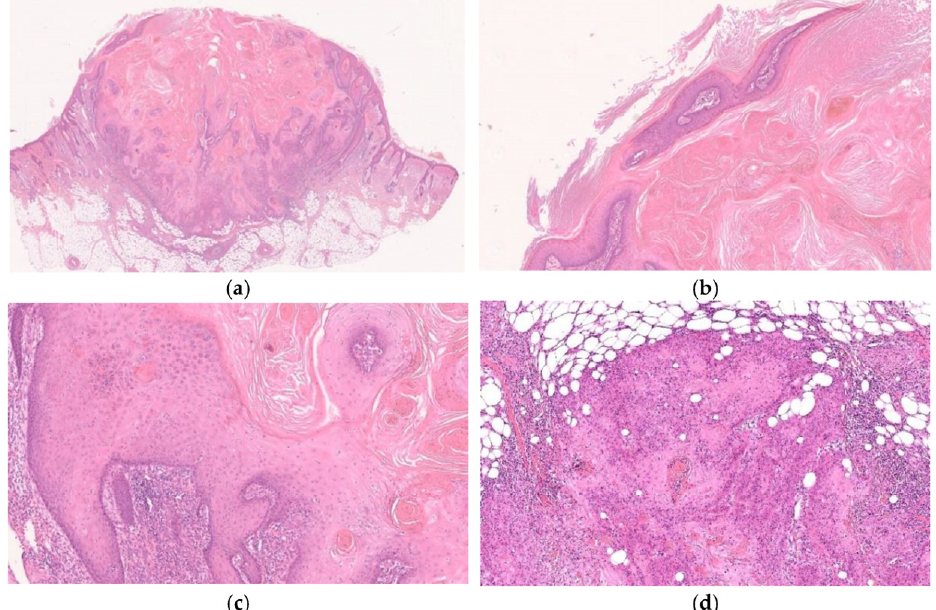
Figure 6. Histopathological findings of KA-like SCC. Gross findings of the lesion include crateriform architecture with a central keratinous plug ( a ). In part of the lesion, the histopathological features of KA are observed ( b , c ), whereas the SCC component is composed of tumor cells with keratinocytic differentiation and apparent nuclear atypia and shows invasive growth pattern ( d ).